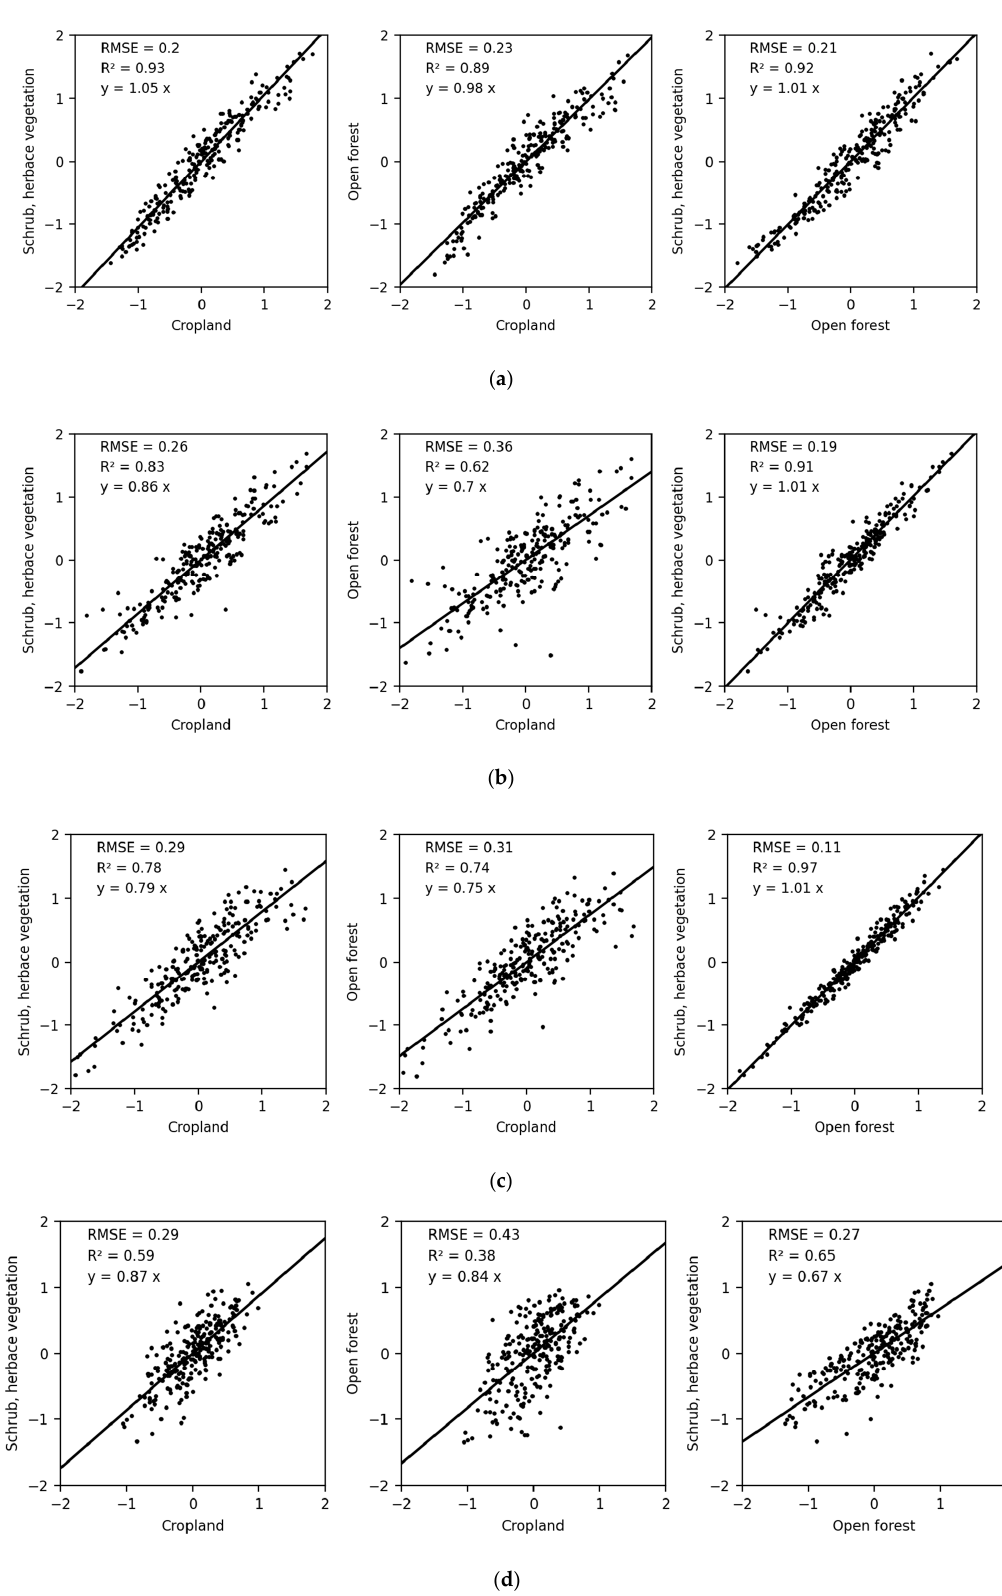
Figure 3. Intercomparison between the VAI values for the different land uses (crop, shrub, and open forests), ( a ) Kairouan, Tunisia ; ( b ) Ain Defla, Algeria ; ( c ) Rif, Morocco; ( d ) Andalusia , Spain .